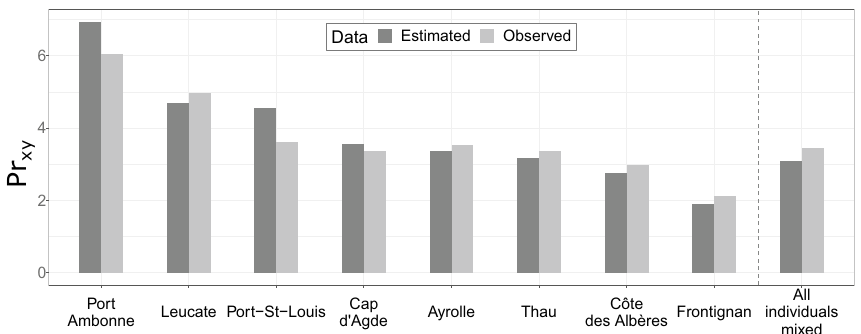
Figure 3. Percentage ( Pr xy ) of Pinna nobilis individuals sharing at least one common parent (i.e. percentage of relations with r xy > 0.25) calculated for each locality and for all sampled individuals mixed. Based on Queller and Goodnight (1989) r xy index for